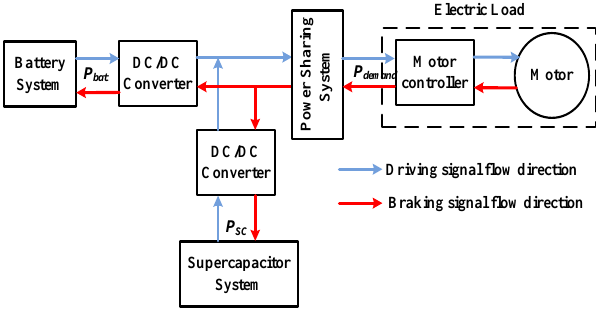
Figure 1. Configuration of battery/supercapacitor hybrid system. DC, direct current.